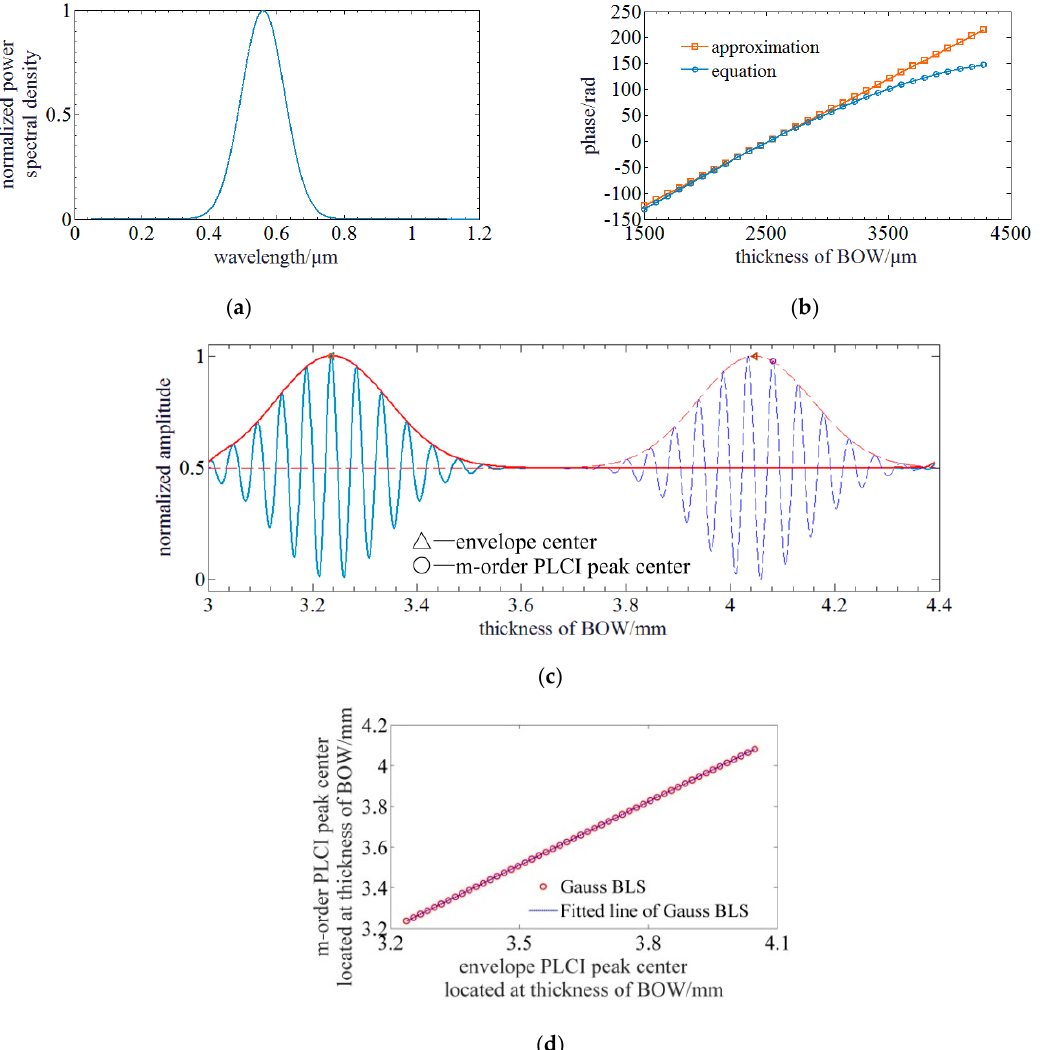
Figure 2. Simulation of PLCI for MADM with a BLS of Gauss profile: ( a ) The profile of the Gauss BLS; ( b ) The phase curves of equation and approximation; ( c ) PLCIF of BLS in Gauss: The solid and dotted lines represent the PLCIFs at different MDs. The blue and red lines represent the measured PLCIFs achieved by SC and envelopes curves achieved by FFT method; ( d ) Relationship between envelope and m ‐ order PLCIF peak center.